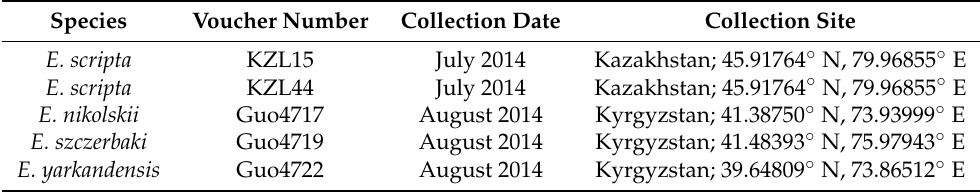
Table 1. List of collection information for five racerunners in Eremias